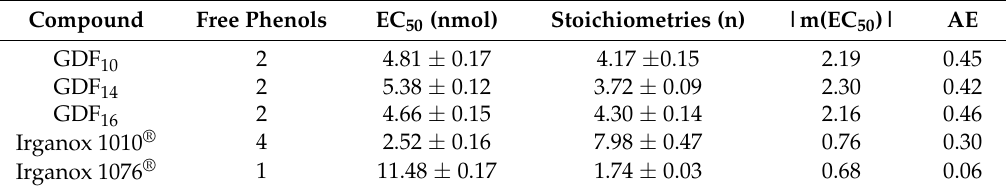
Table 3. Radical scavenging parameters of phenolic antioxidants.